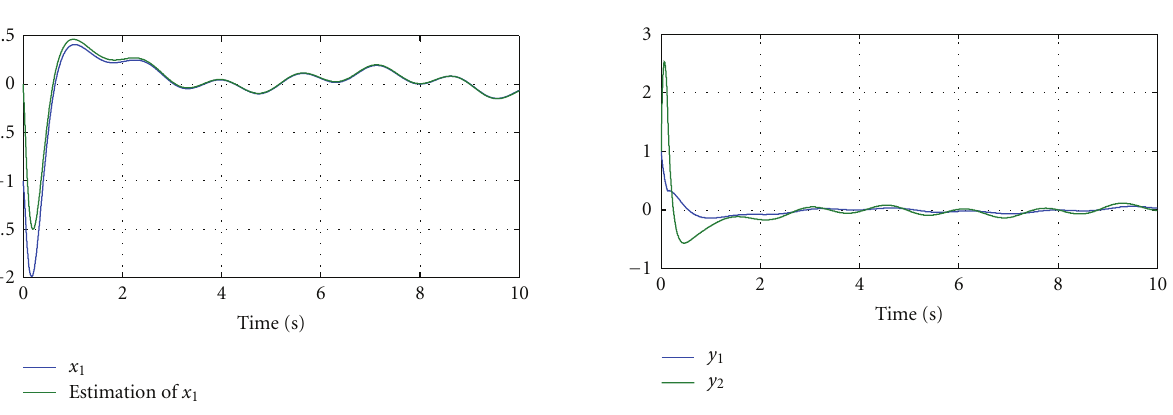
Figure 5: True and estimation values of x 1 for Example 6.